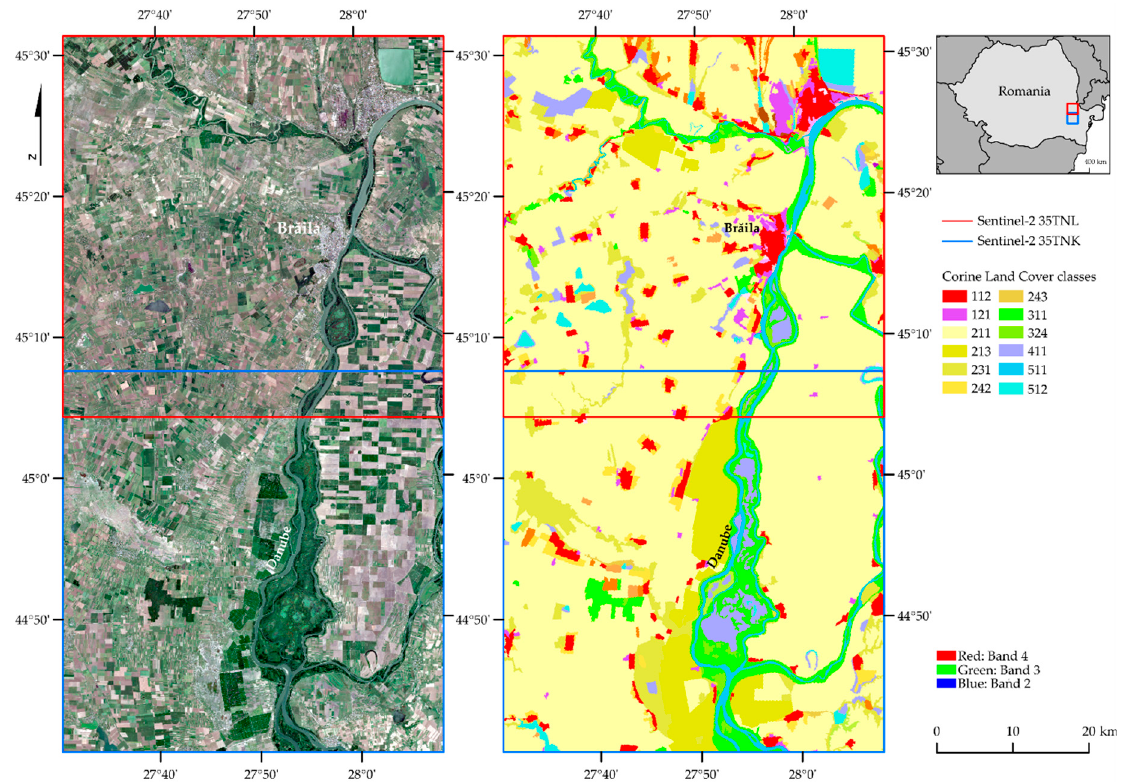
Figure 1. Location of South and North Braila areas (source: own study based on Sentinel-2 images, European Space Agency, 2018 and the Corine Land Cover map of the European Environment Agency, 2018). Codes: 112: discontinuous urban fabric; 121: industrial or commercial units; 211: non-irrigated arable land; 213: rice fields; 231: pastures; 242: complex cultivation patterns; 243: land principally occupied by agriculture, with significant areas of natural vegetation; 311: broad-leaved forest; 324: transitional woodland/shrub; 411: inland marshes; 511: water courses; 512: water